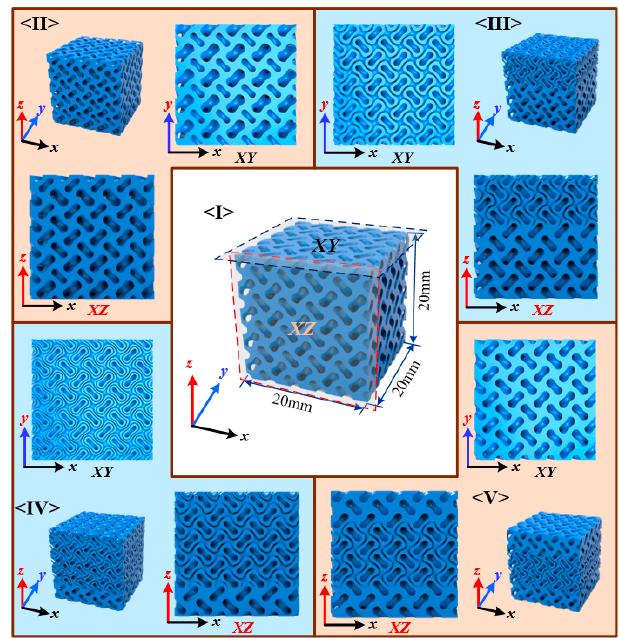
ff erent types of sheet structure for experimental Figure 4. Five different types of sheet structure for experimental investigation. Figure 4. Five di